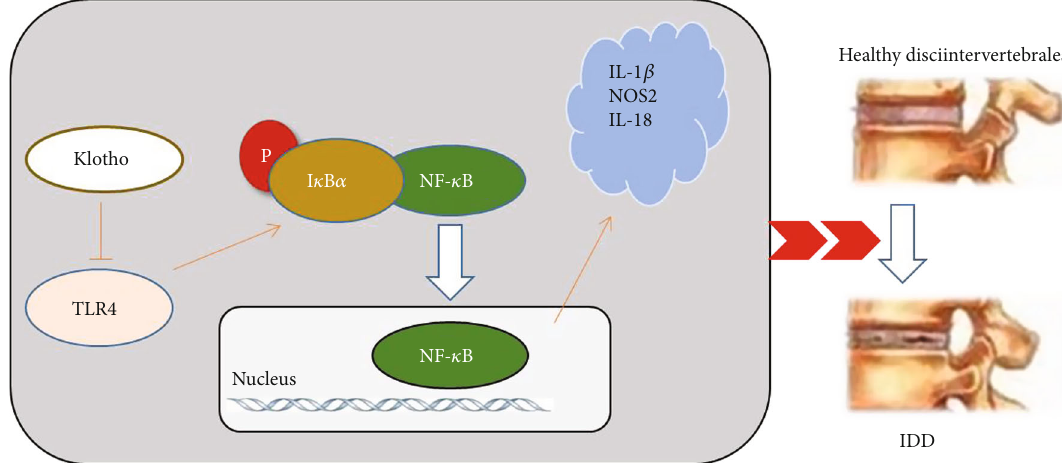
Figure 6: Schematic of Klotho suppression of TLR4 and inhibition of TLR4-NF- κ B in fl ammatory